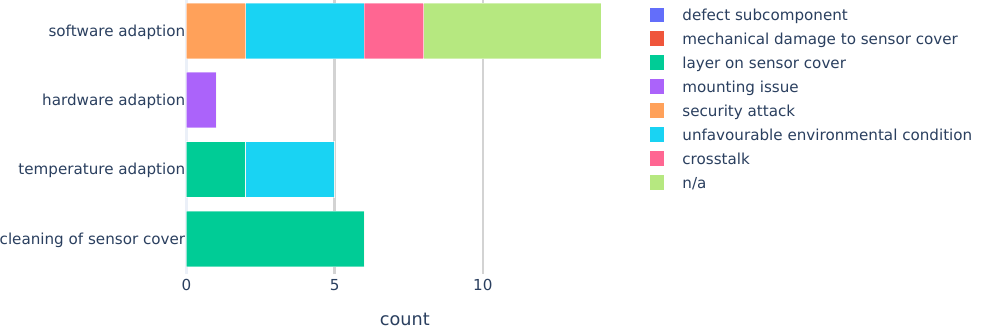
Figure 8. Recovery class count colour coded by fault